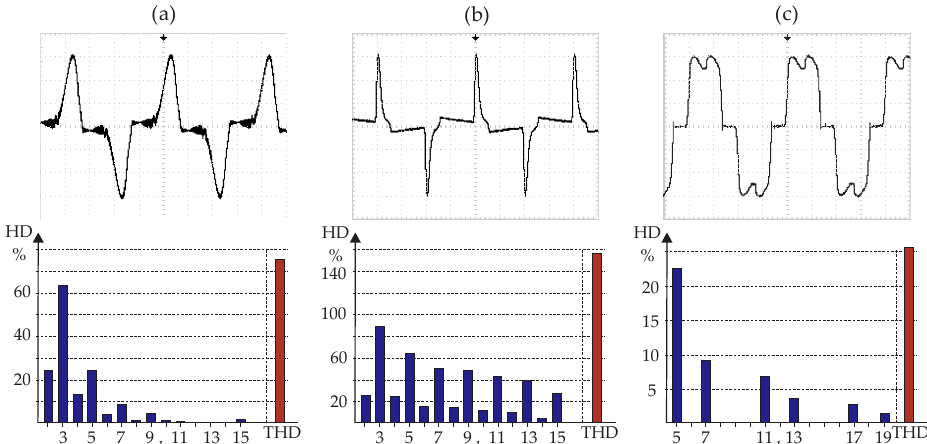
Figure 1. Examples of waveforms and harmonic spectra with distorted current: ( a ) single-phase pulse power supply, ( b ) energy-saving light bulb, ( c ) three-phase converter drive.